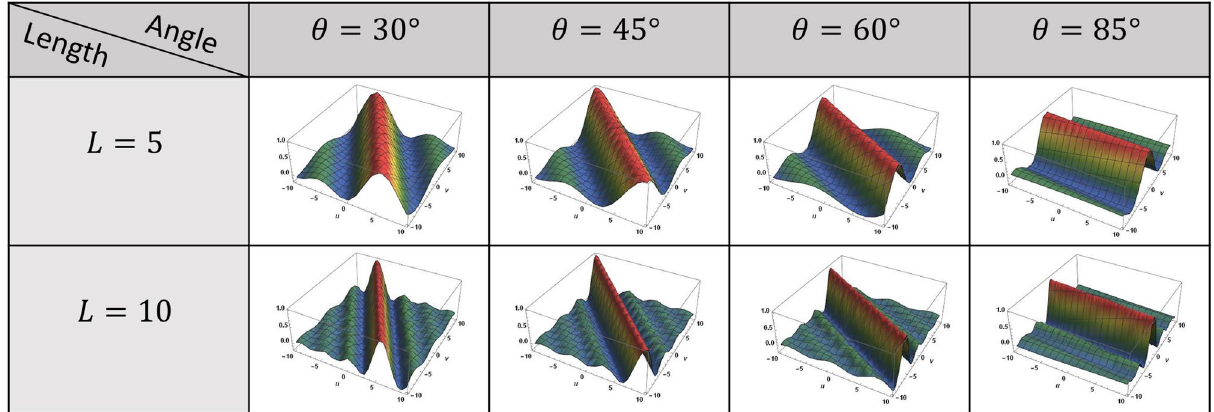
5, 10 ) and angles =